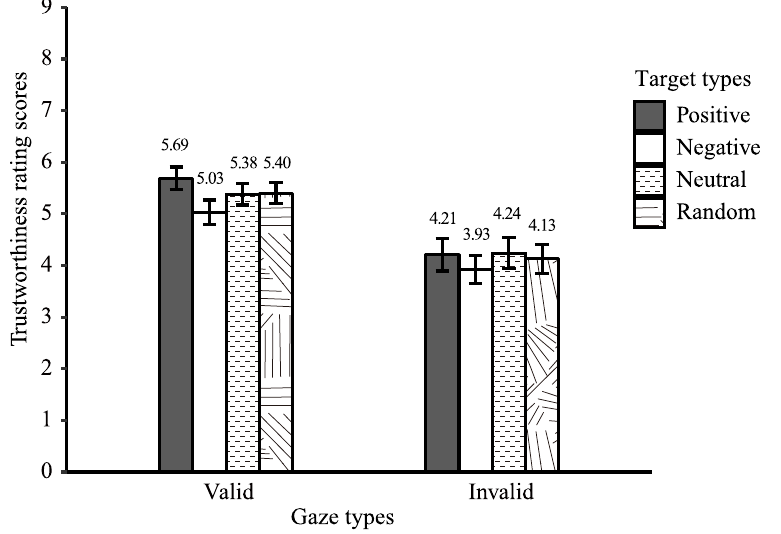
Fig 6. Trustworthiness for each type of gazes and targets in Experiment 2. Error bars represent the standard error of the mean ( SEM ). Means of trustworthiness scores for each condition are shown above each bar.